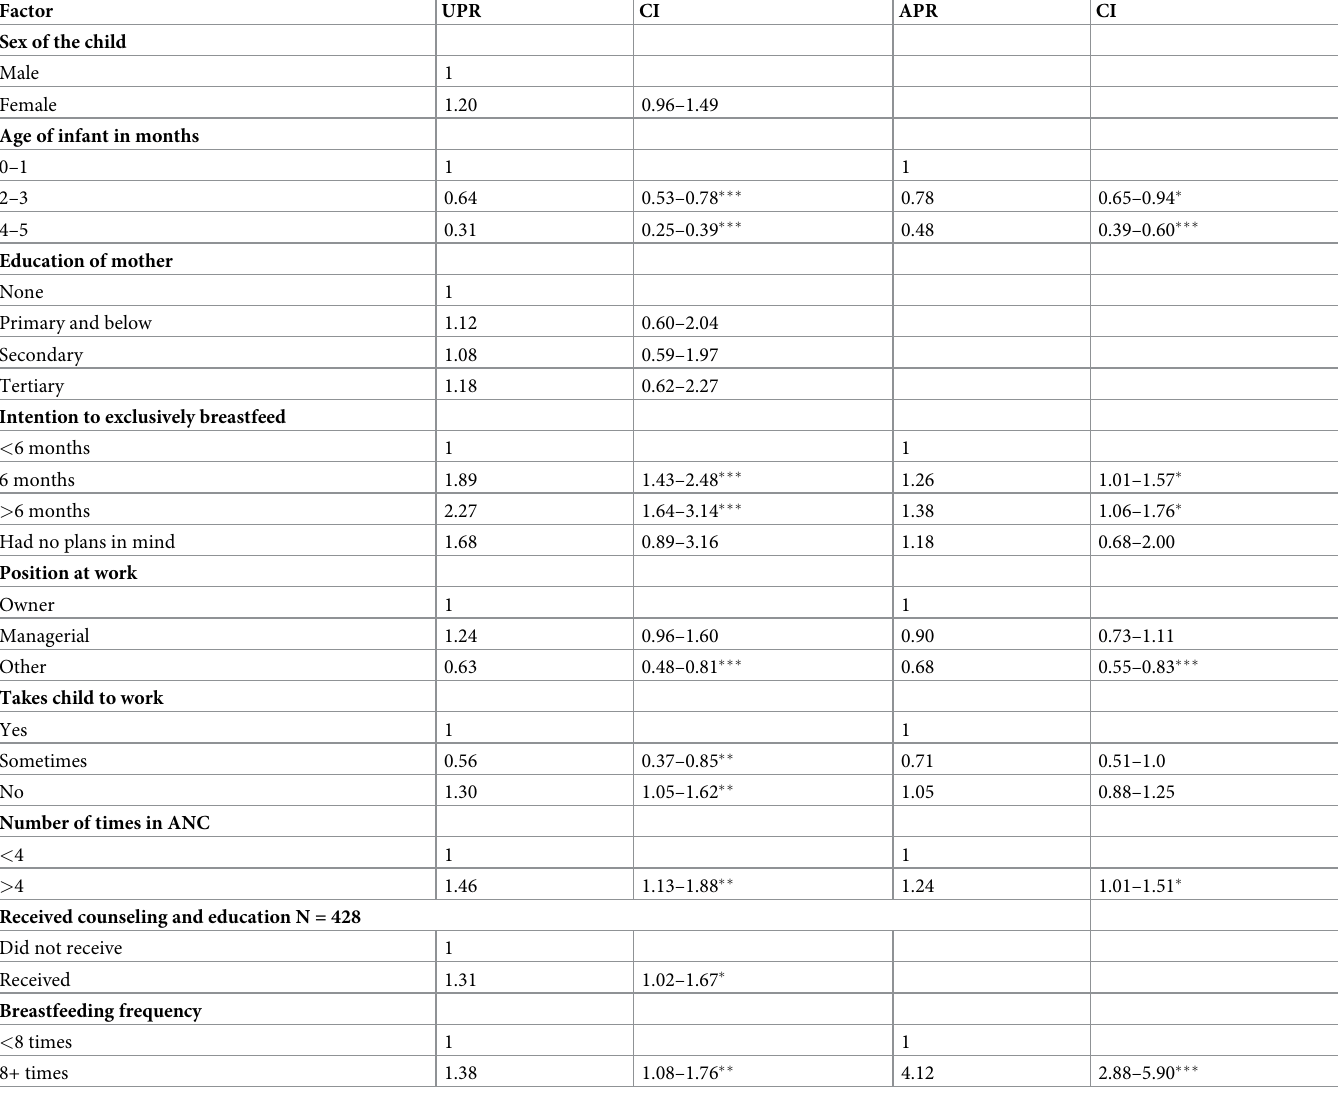
Table 4. Determinants of exclusive breastfeeding among mothers working in the informal